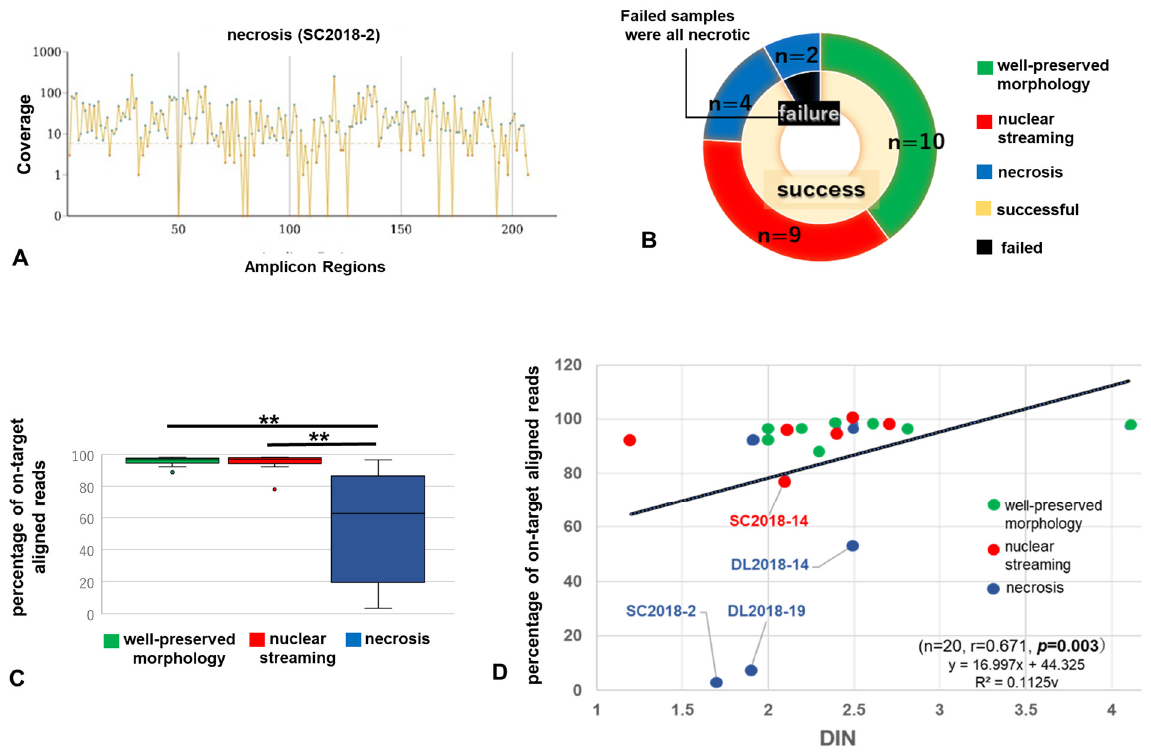
Figure 3. Amplicons with a coverage <×500 ( A ) (necrosis in SC 2018-2). All samples that failed NGS were necrotic ( B ). Differences in percentage of on-target aligned reads among three histological groups ( C ). Positive correlation between the percentage of on-target aligned reads and DIN ( D) (green, materials with well-preserved tumor morphology; red, nuclear streaming; blue, necrosis). DIN, DNA integrity number; SC, small cell lung carcinoma; DLBCL, diffuse large-B-cell lymphoma. (**, p < 0.01).